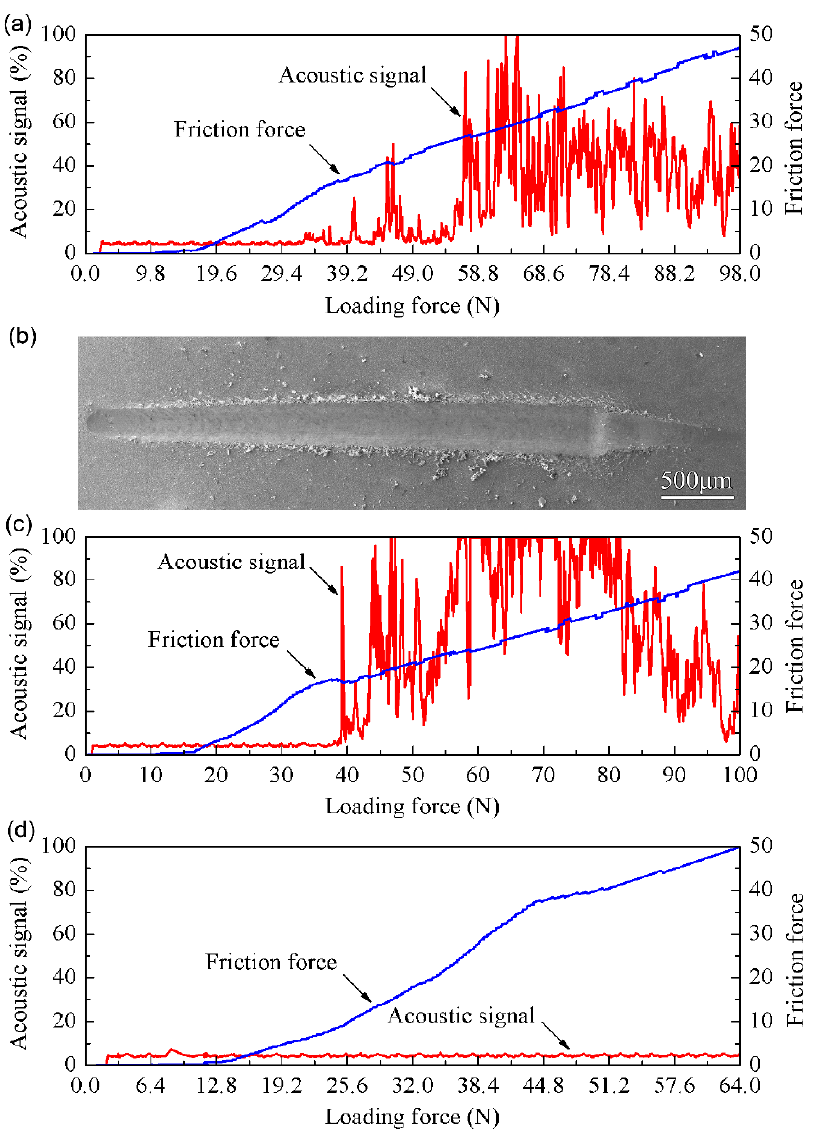
Figure 16. The scratching curves and surface morphology of the multiphase coating after plasma nitriding: ( a ) the scratching curves of F1 film, ( b ) SEM micrograph of the scratching groove of F1 film, ( c ) the scratching curves of F2 film, and ( d ) the scratching curves of F3 film.